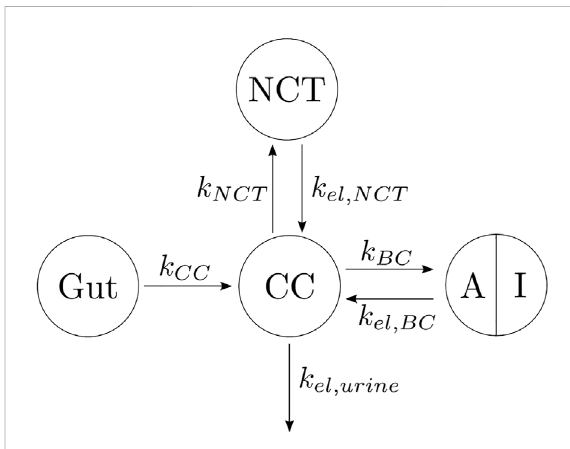
FIGURE 4 Three-compartment model “ in parallel ” , adapted with the divisionoftheBCcompartmentintoanactive(A)andaninactive(I) subcompartment.